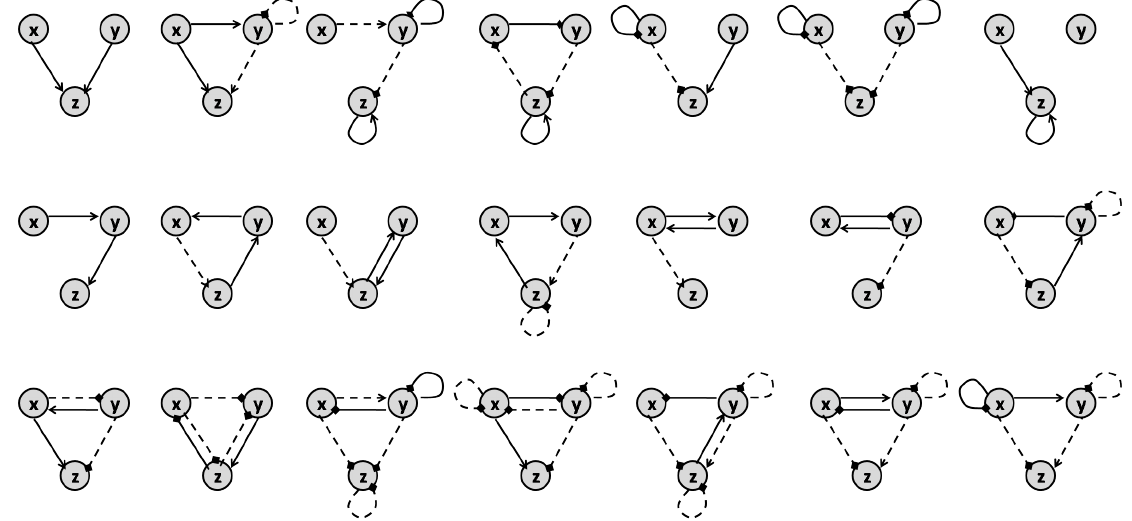
Figure 10. General representation of a three-node network where the dashed lines can be replaced by an arrow for activation or a blockage for inhibition. There would be no connection for no interaction.